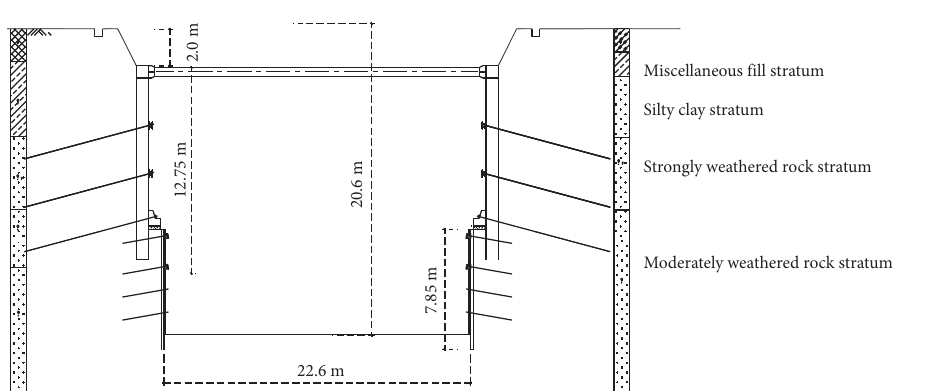
Figure 14: Section of station foundation pit support structure (section 7-7). Table 11: Statistical analysis of monitoring data cumulative